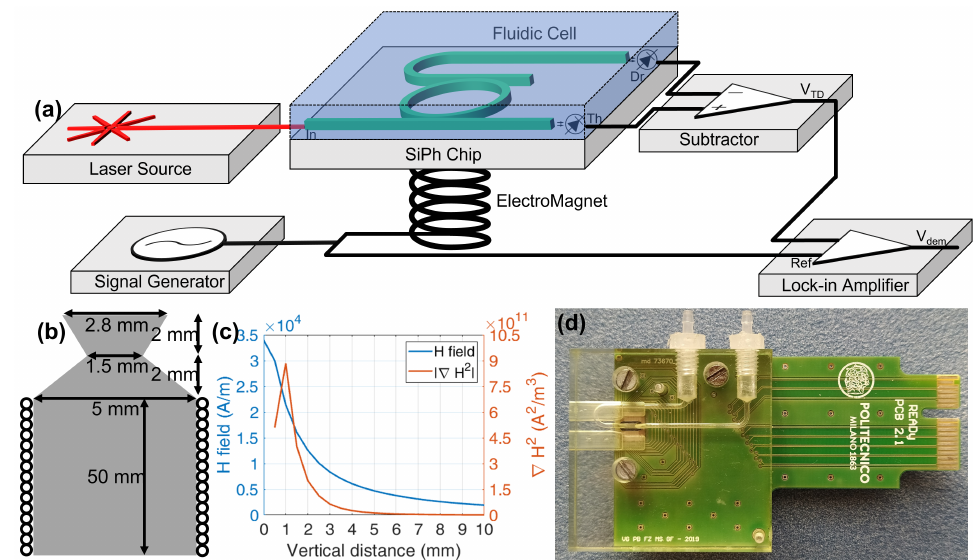
Figure 4. Opto − Magnetic platform. ( a ) Conceptual setup scheme: tunable laser source with drivers, integrated photonic chip in the microfluidic cell, LIA, signal generator with electromagnet; ( b ) Elec- tromagnet geometry and ( c ) experimental magnetic field characterization; ( d ) photo of the Printed Circuit Board with SiPh chip and the assembled fluidic cell